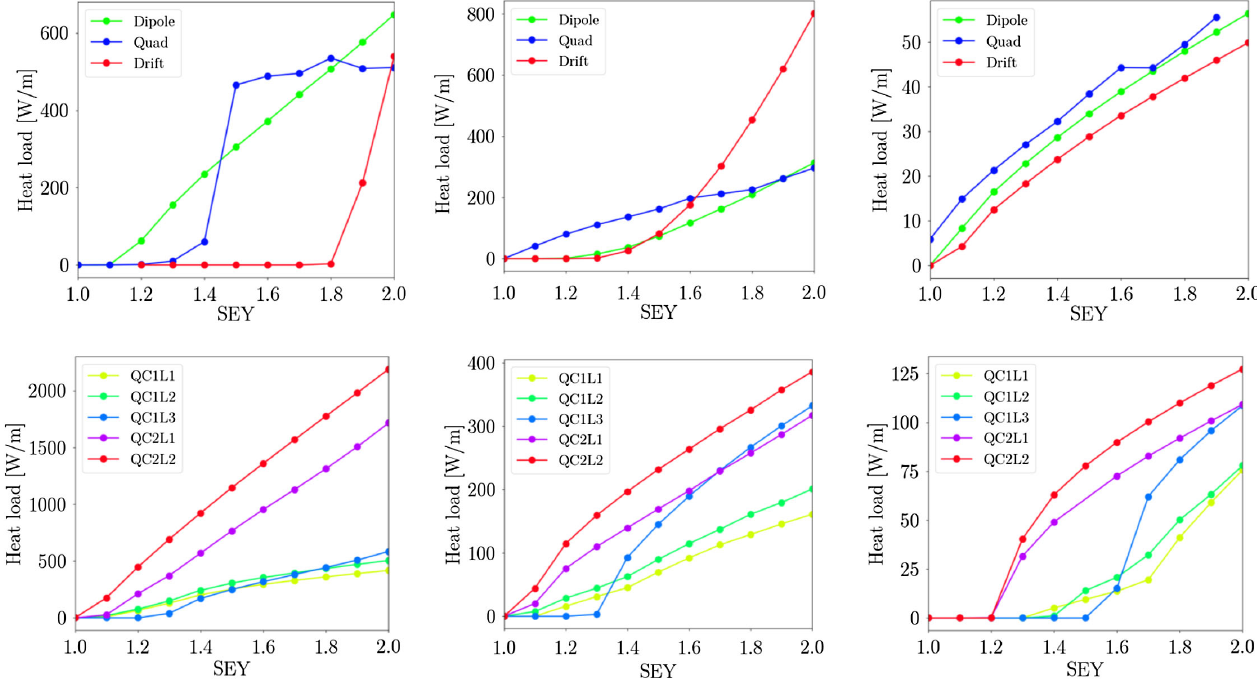
FIG. 2. Heat load as a function of SEY for arc components (top) and IR magnets (bottom) in the case of 2.5 ns (left side), 5 ns (center) and 15 ns (right side) bunch spacings.